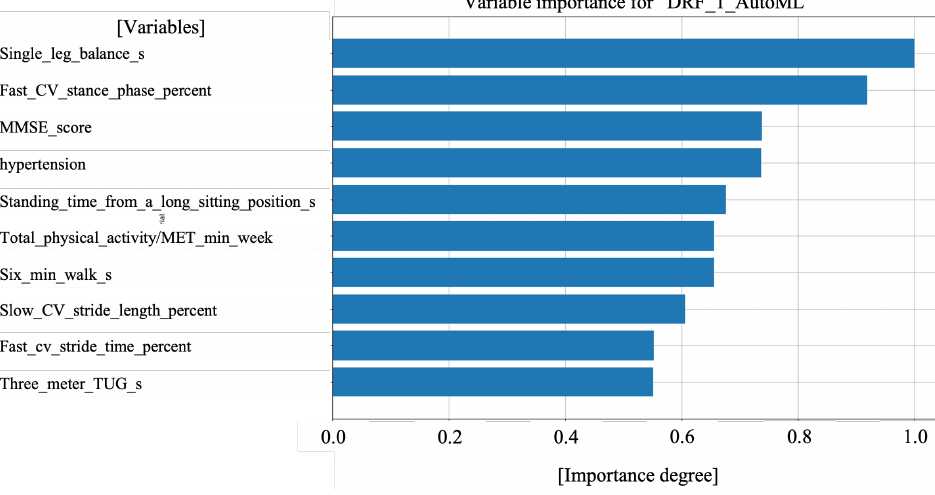
Figure 9. Results of variable importance plot, which show the relative importance of the most important variables in the